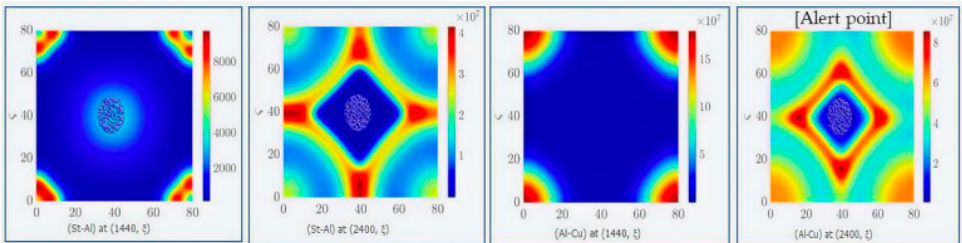
Figure 8. The change in the (Fe-Al) and (Al-Cu) alloys resistance working condition for thermal transfer.